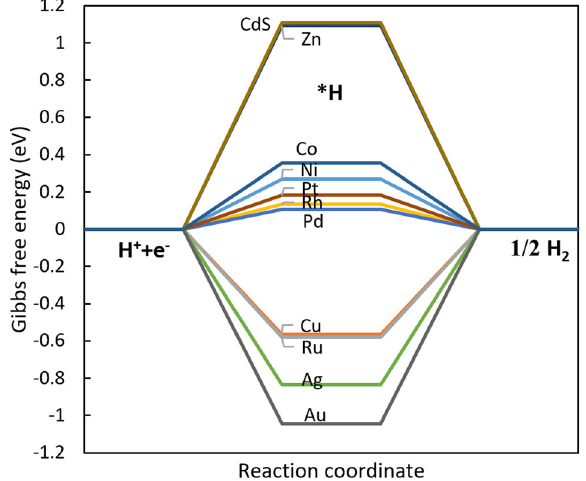
Fig. 7 Gibbs free energy diagrams of the pristine CdS surface and TM@CdS surfaces for HER. H* indicates the adsorbed hydrogen atom on the doped CdS surface. Data are available in Zenodo.